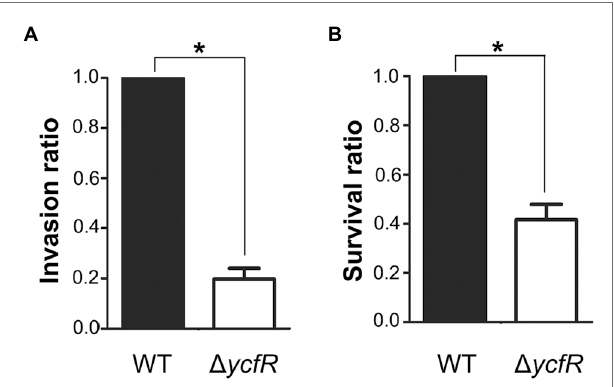
FIGURE 1 | Invasion and survival of a Δ ycfR mutant in the host cell. (A) Invasive ability of wild-type and Δ ycfR mutant strains was assessed by infecting HeLa cells and counting intracellular bacteria 2 h post-infection. The bar indicates relative invasion ability compared to wild-type Salmonella . (B) Survival inside RAW264.7 macrophages was compared between wild- type and Δ ycfR mutant strains 10 h post-infection. The numbers phagocytosed by macrophages were found comparable between two strains (data not shown) and relative survival ratios are depicted. A significant difference (value of p < 0.05) is denoted with an